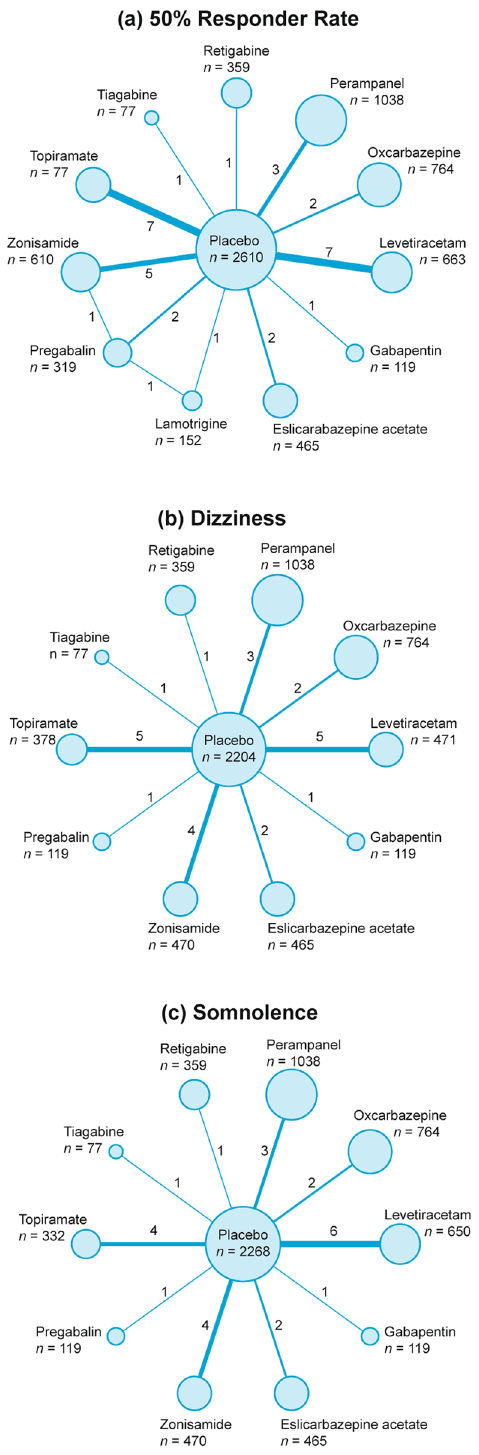
Figure 1. Network diagram for 50% responder rate, dizziness and